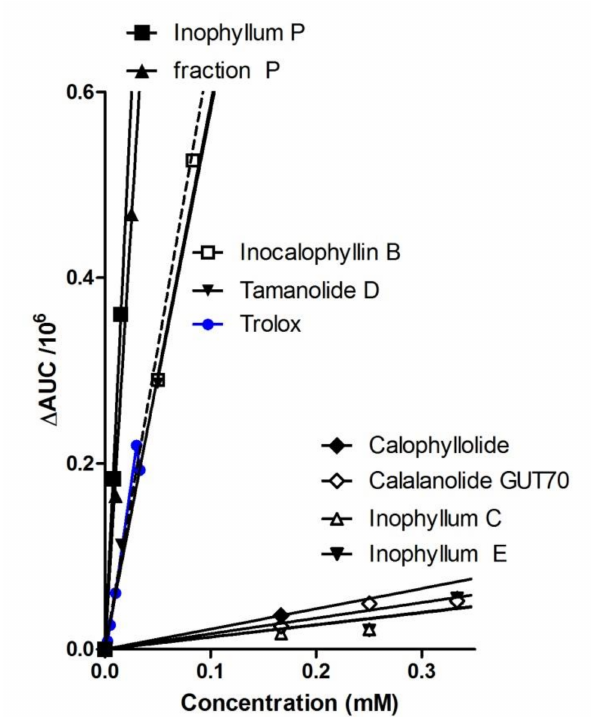
Figure 2. Superoxide scavenging capacity of TO extracts metabolites by TRAP luminescence as- say. Linear correlations plots are expressed as area under the curve ( ∆ AUC) versus compounds concentrations. In fraction P, inophyllum P accounts for ~70% in